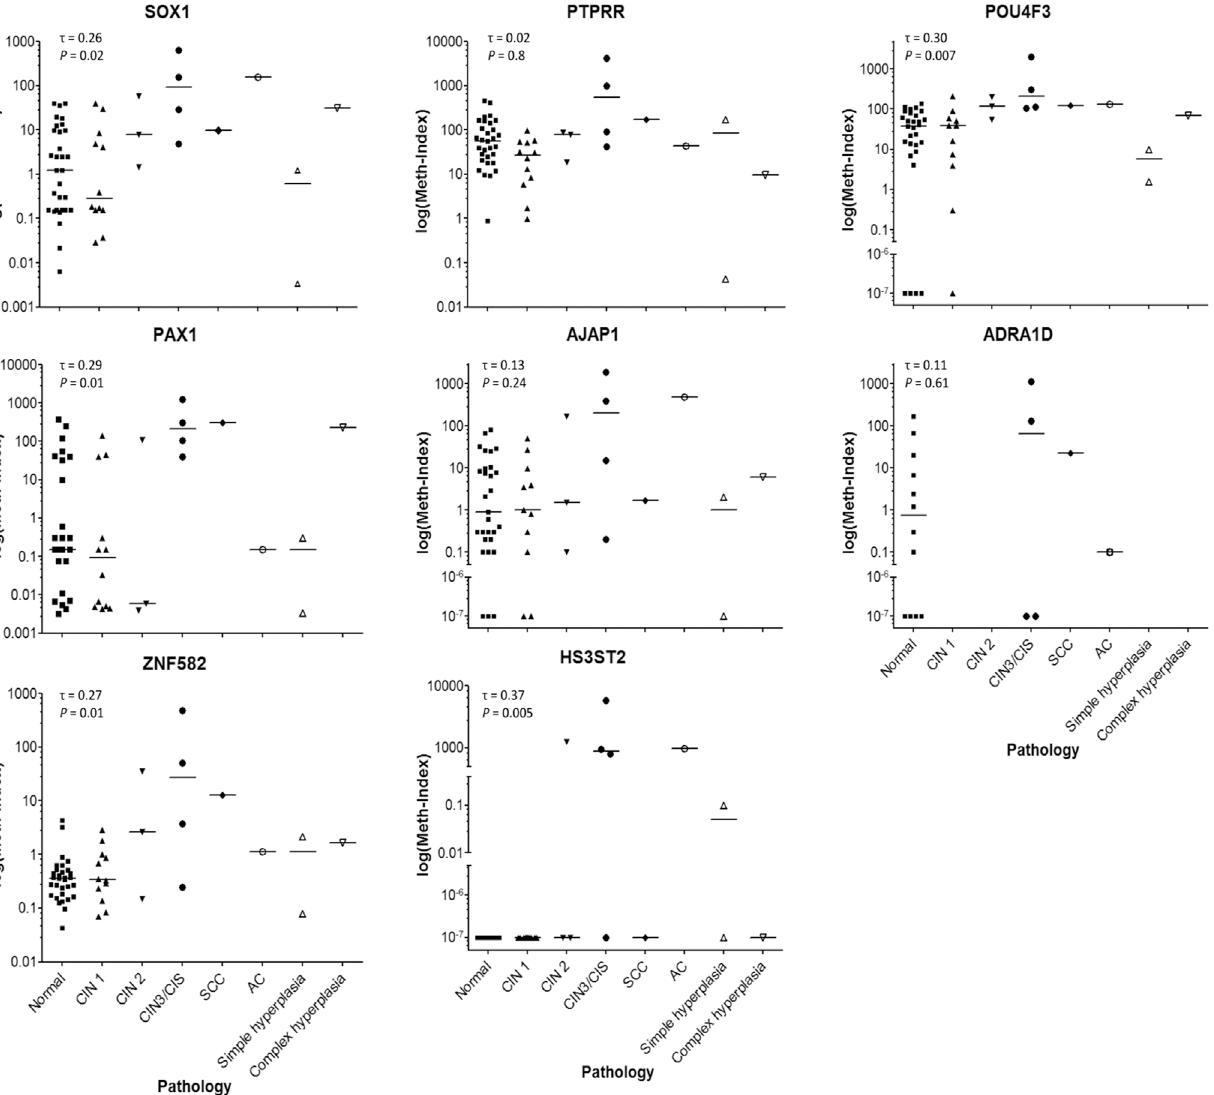
Fig 2. Methylation index (meth-index) on a log scale of methylated ( m ) SOX1 m , PAX m , ZNF582 m , PTPRR m , AJAP1 m , HS3ST2 m , and POU4F3 m levels from scrapings of the normal cervix and tumors graded as CIN1, CIN2, CIN3, CIS, or SCC/AC, or endometrial lesions (including simple hyperplasia and complex hyperplasia of the endometrium) by histopathology. Each dot represents the testing result of one